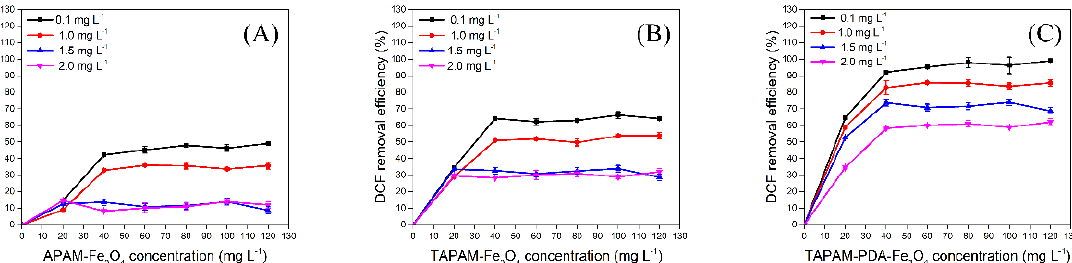
Figure 7. Effect of the DCFS initial concentration on enrichment properties (( A ) for APAM-Fe 3 O 4 , ( B ) for TAPAM-Fe 3 O 4 , ( C ) for TAPAM-PDA-Fe 3 O 4 ).